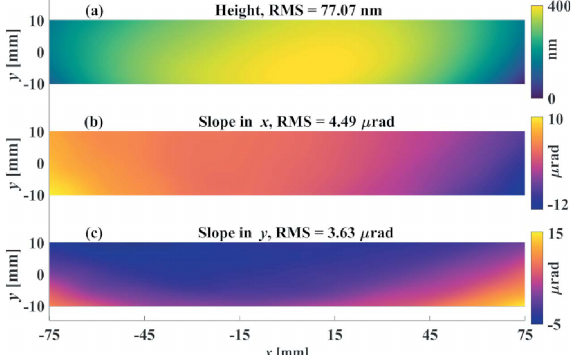
Figure 5 Height ( a ), slope in x ( b ) and slope in y ( c ) of an analytical surface generated with a 260-order Chebyshev polynomial.